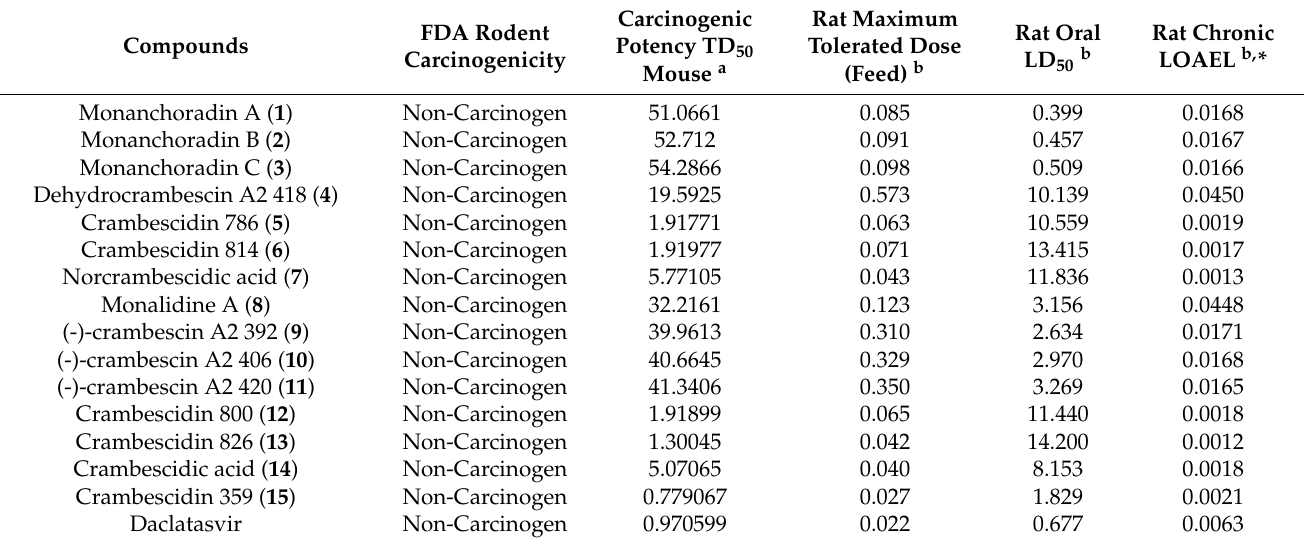
Table 3. Toxicity properties of the most promising compounds ( 1 – 15